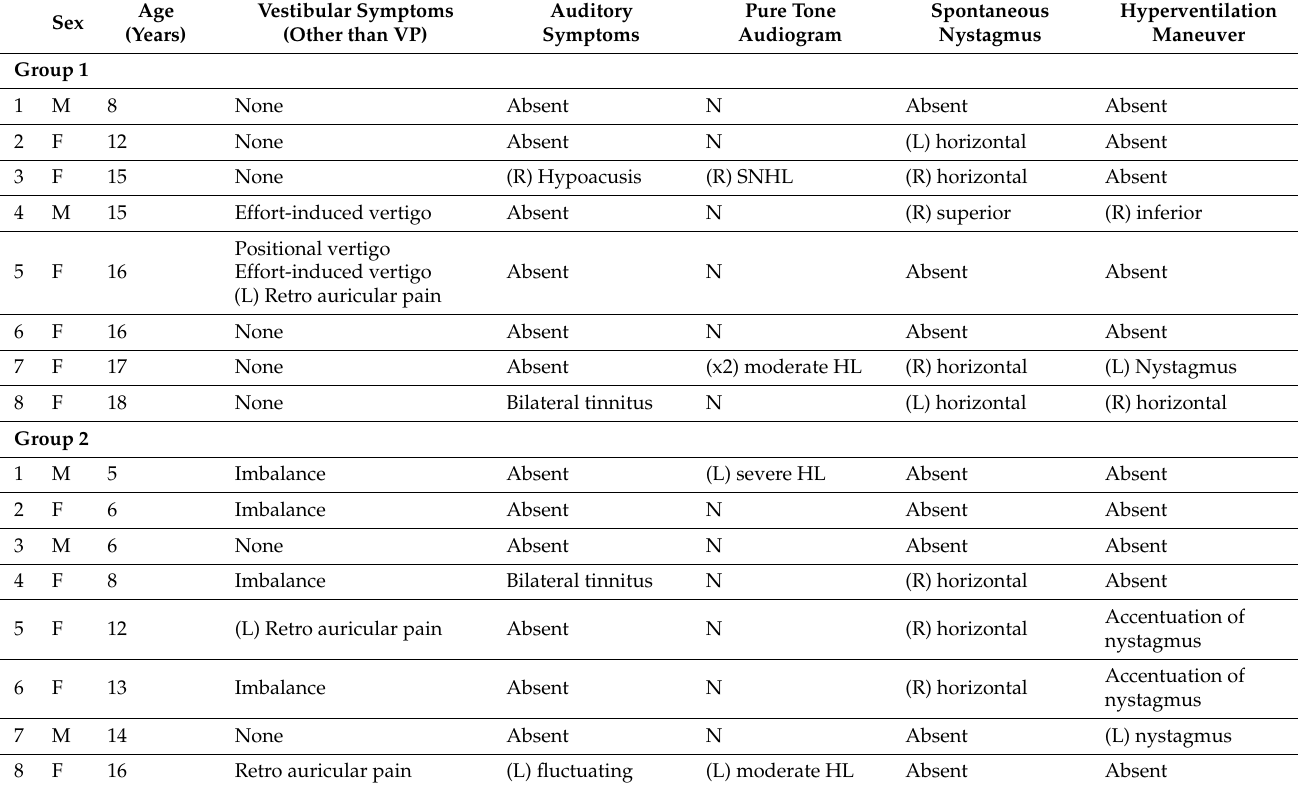
Table 1. Demographic and clinical data for Groups 1, 2, and 3. Abbreviations: F (female), HL